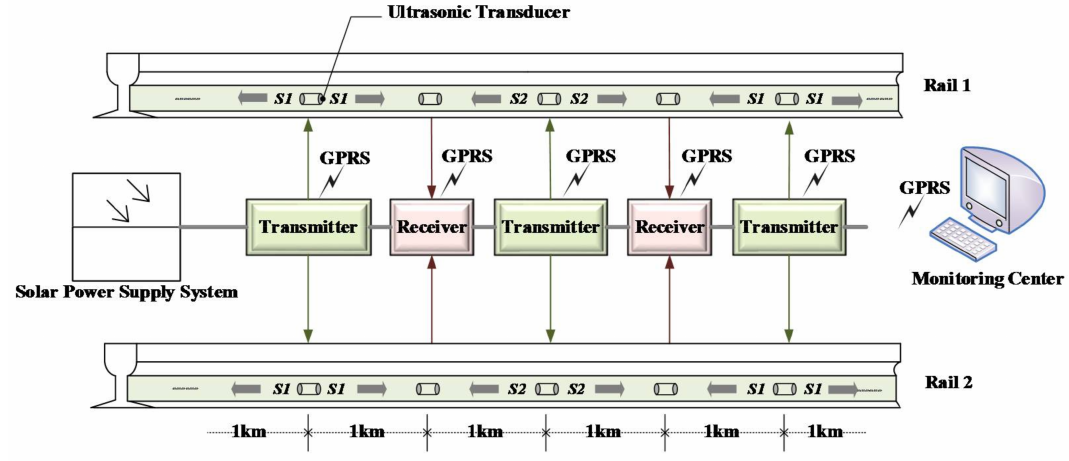
Figure 1. Typical structure for the UGW-based track monitoring